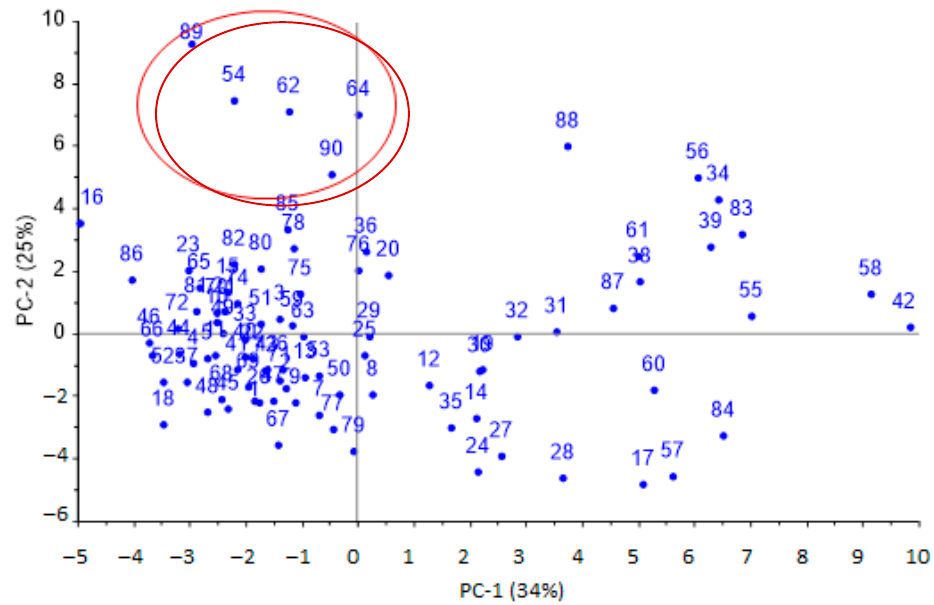
Figure 3. Scores plot of the PCA model for urine samples by identification parameters (sample numbers correspond to the number in Table 1,the plot with high resolution in Supplementary Materials, Figure S5).